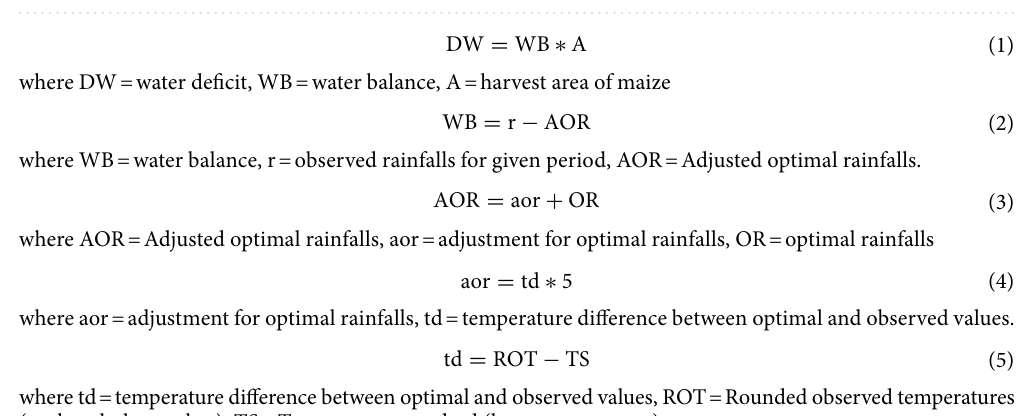
Figure 1. Map of the Czech Republic with annual temperature and precipitation in January and